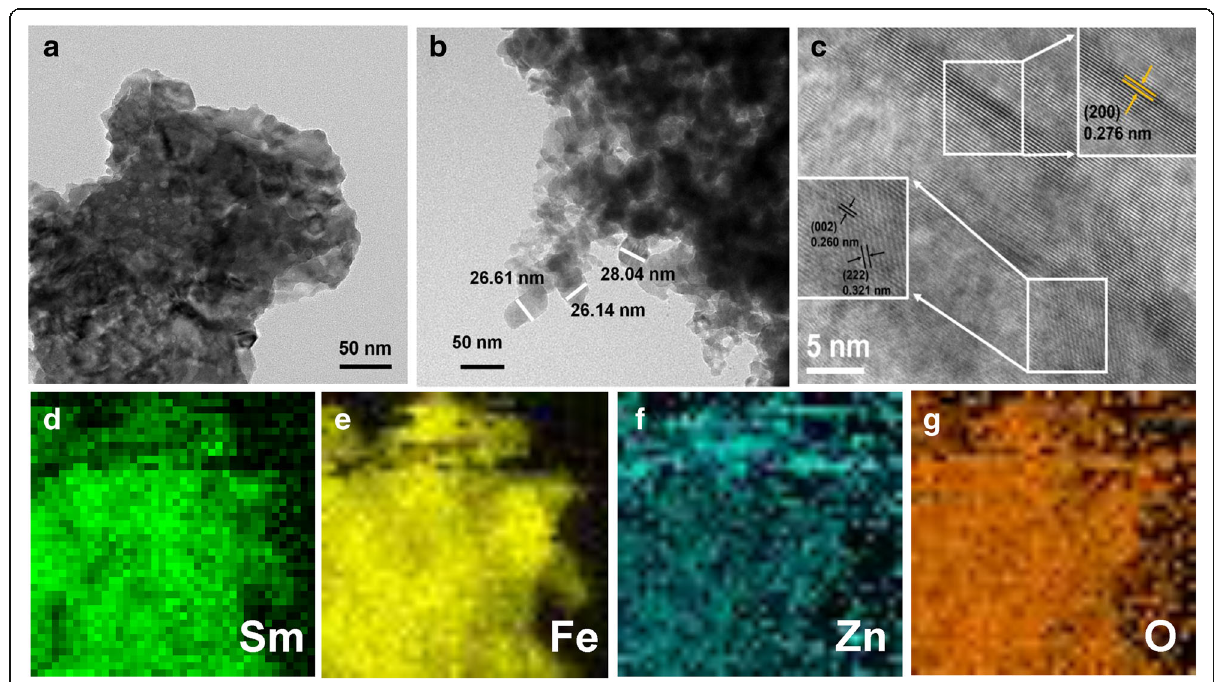
Fig. 5 a , b TEM images and c HRTEM images of S3. STEM element mapping of S3 for Sm ( d ), Fe ( e ), Zn ( f ), and O ( g